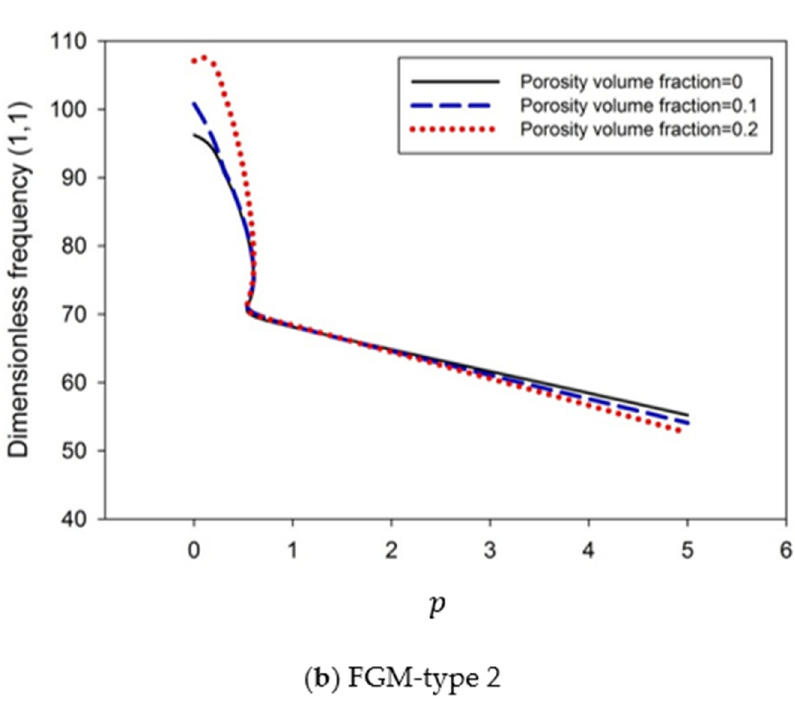
Figure 7 . Dimensionless frequency of FG porous spherical shell versus different power ‐ law indices Figure 7. Dimensionless frequency of FG porous spherical shell versus different power-law indices for for various porosity volume fractions: ( a ) FGM ‐ type 1, ( b ) FGM ‐ type 2. various porosity volume fractions: ( a ) FGM-type 1, ( b ) FGM-type 2. Appl. Sci. 2017 , 7 , 1252